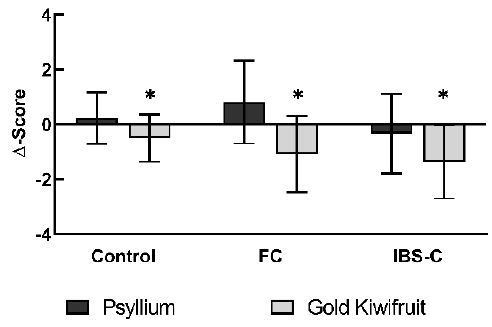
Figure 5. Changes in weekly straining scores. ∆ -score: median score after subtraction of pre-intervention score from post-intervention = relative shift from baseline. Bars: arithmetic means, error bars: 95% confidence intervals. Positive score = increase in symptom, negative score = decrease in symptom. n = 56. Asterisks indicate statistical significance. * = Statistical significance between gold kiwifruit and psyllium, p = 0.021. FC, Functional Constipation: IBS-C, Constipation-predominant Irritable Bowel Syndrome.